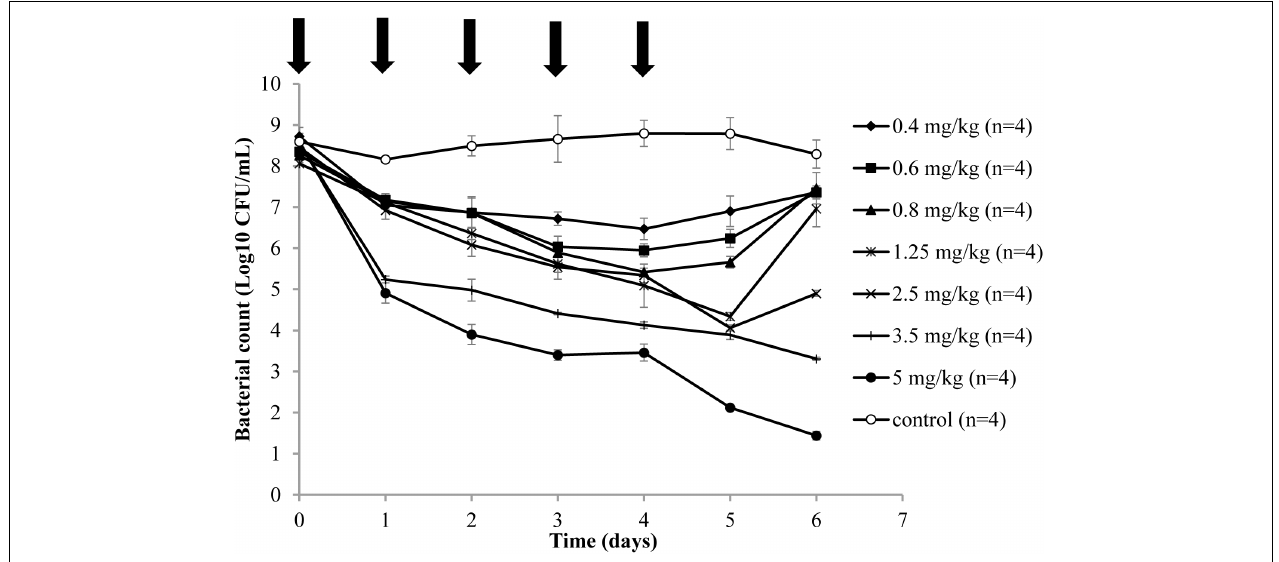
FIGURE 1 | Time-killing curves in the tissue cage fluid of danofloxacin treatment of A. pleuropneumoniae CVCC259. After an infection model was established, various doses (0.4, 0.6, 0.8, 1.25, 2.5, 3.5, and 5 mg/kg of body weight by IM) of danofloxacin and sterile physiological saline (control group) were administered intramuscularly once daily for 5 days (indicated by the arrow). n is the number of tissue cages per group.